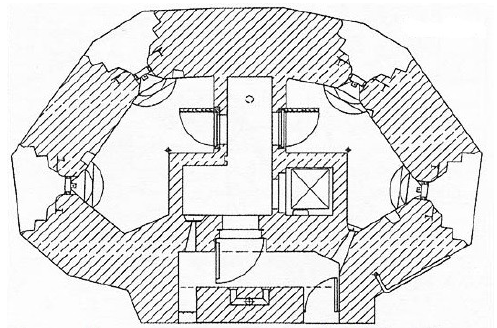
Figure 6. Horizontal cross-section of machine gun pillbox № 428 on upper floor (Kainaran, et al. 2011)